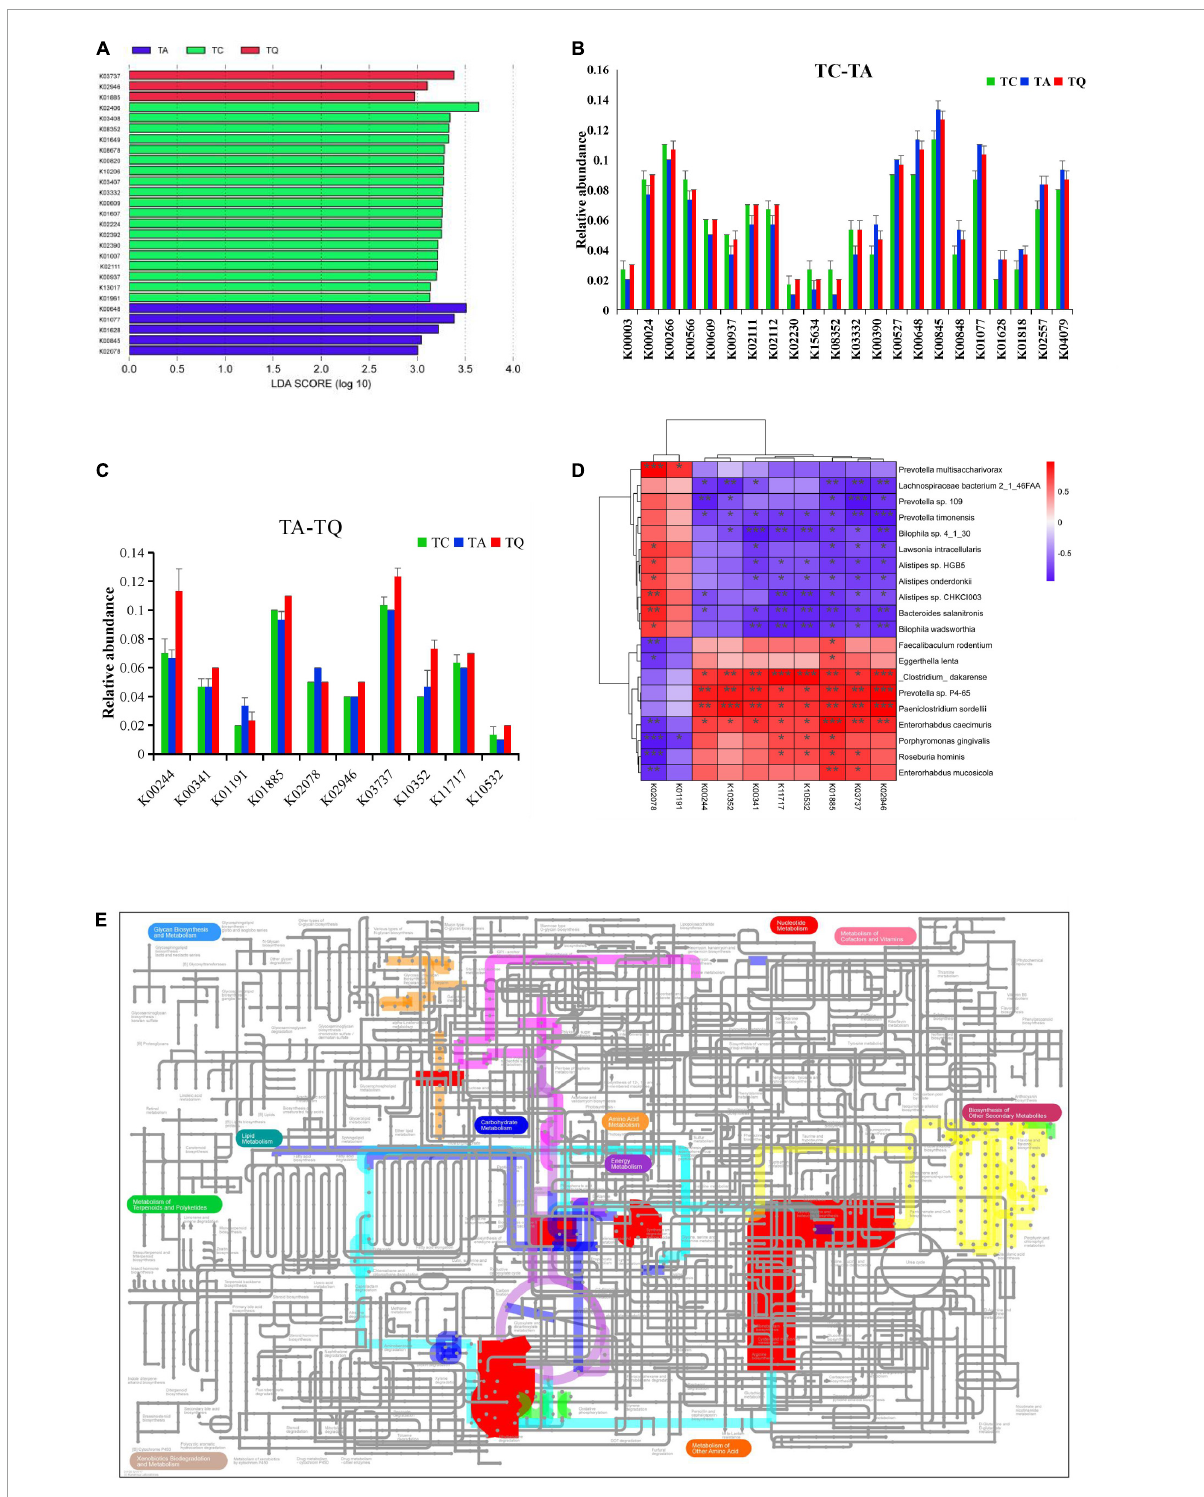
FIGURE4 Quercetin effects on gene expression profile of gut microbial. (A) LDA analysis of 80 genes which annotated on significantly different metabolic pathways; (B) Significantly different genes between TC and TA; (C) Significantly different genes between TA and TQ; (D) Spearman correlation analysis of 10 genes and significantly different bacteria species between TA and TQ; (E) iPath diagram of 10 genes and their related metabolic pathway, different color line indicate different metabolic